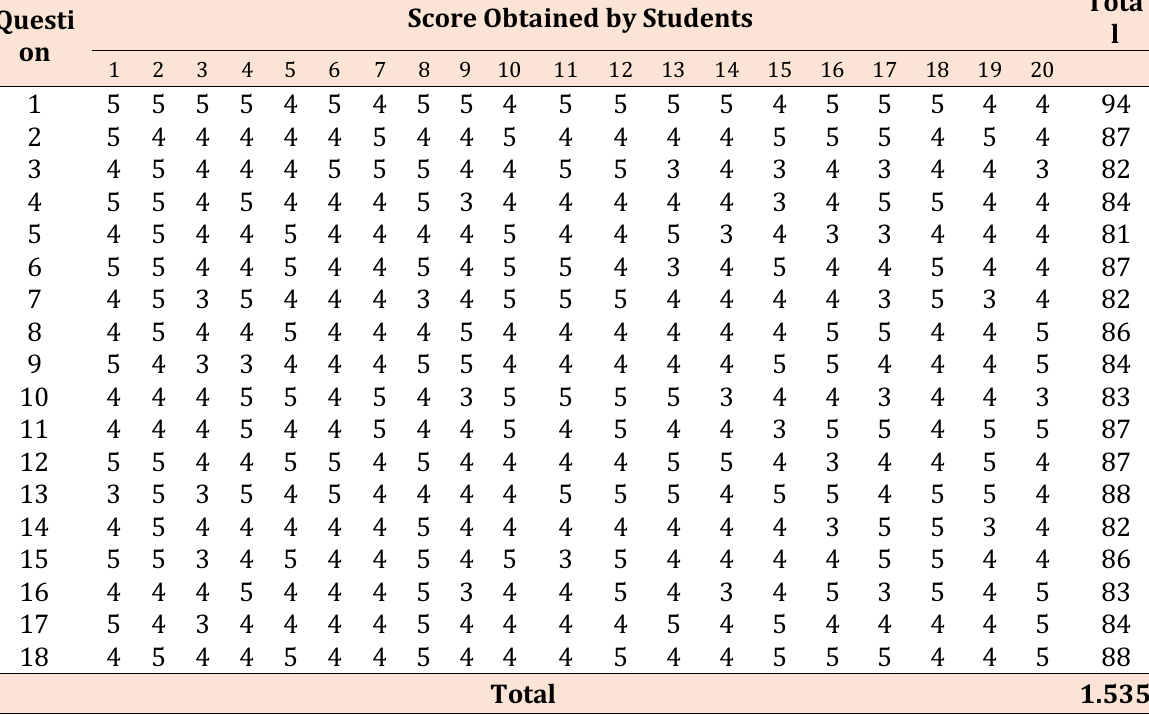
Table 6. Implementation Collected